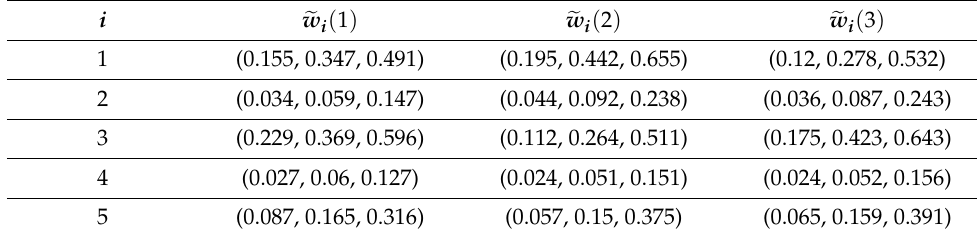
Figure 5. Comparison of the fuzzy priorities of criteria.